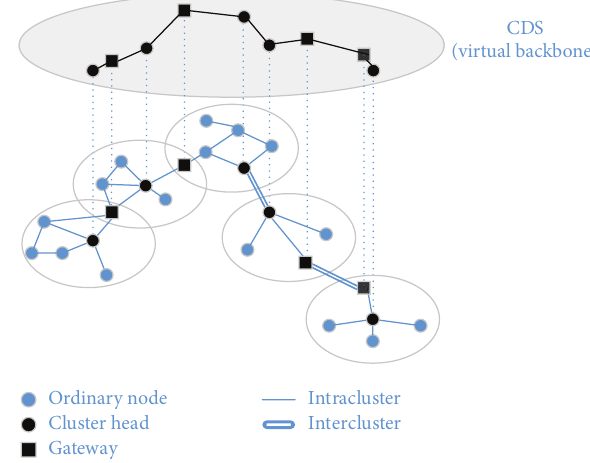
Figure 1: Cluster